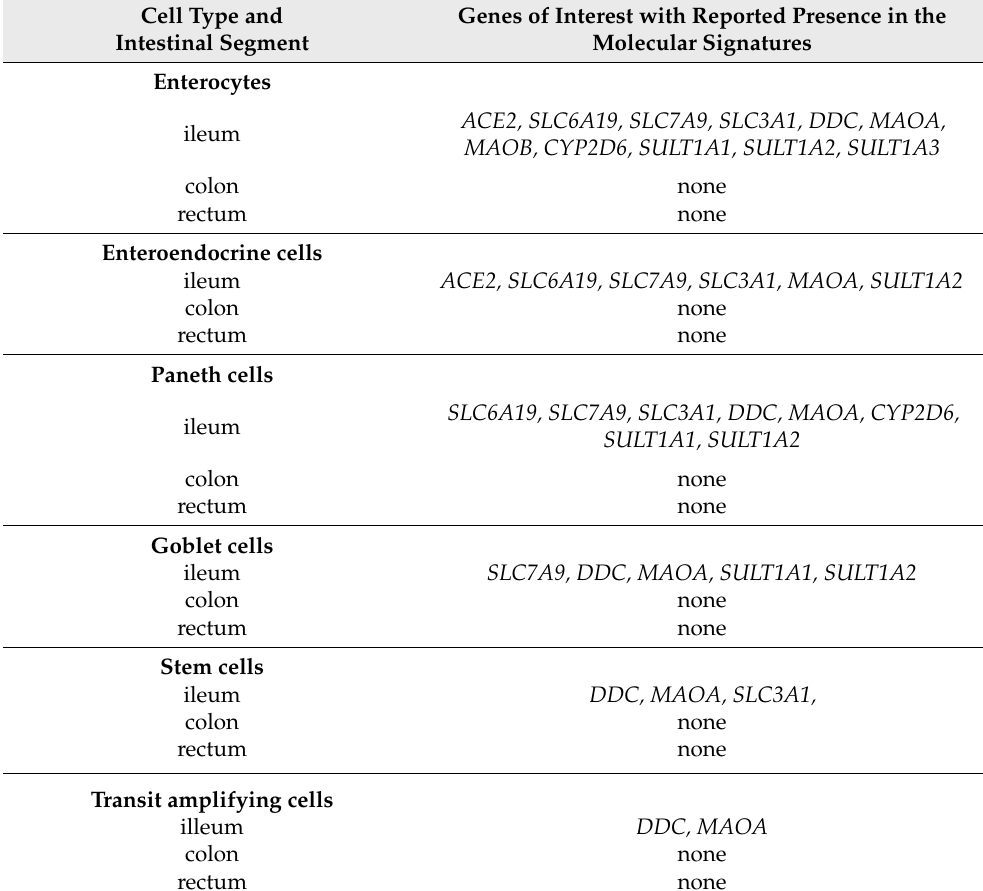
Table 2. Mining of single cell RNA-seq data obtained from the analysis of human gut